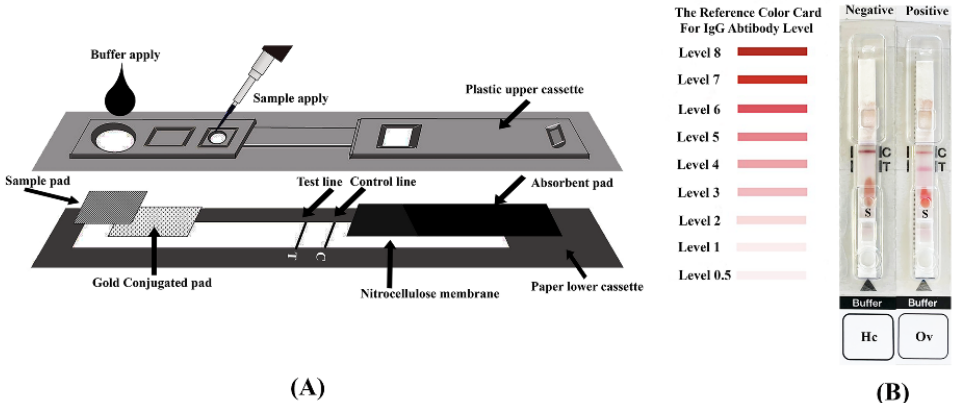
Figure 1. ( A ) Schematic illustration of the OvB-test kit for the blood sample, and ( B ) the positive and Figure 1 . ( A ) Schematic illustration of the OvB - test kit for the blood sample, and ( B ) the positive and negative results are shown with a reference board. A red band appears at the C line in the negative negative results are shown with a reference board . A red band appears at the C line in the negative case ( Hc ) and two bands appear at the C and T lines in the opisthorchiasis ( Ov ). The reference color case (Hc) and two bands appear at the C and T lines in the opisthorchiasis (Ov). The reference color card positive for the IgG antibody level is also shown ( cutoff 0 . 5 or more ). card positive for the IgG antibody level is also shown (cutoff 0.5 or